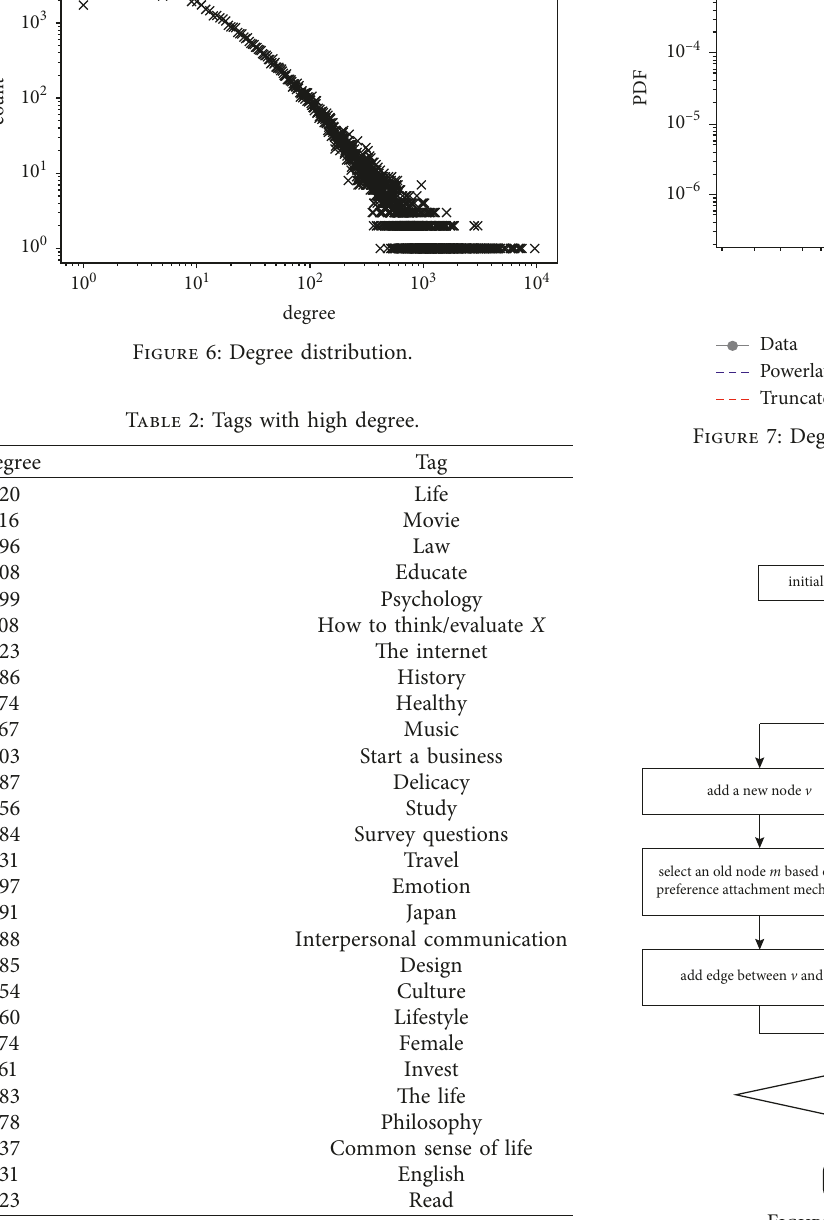
Figure 8: Simulation flow chart.